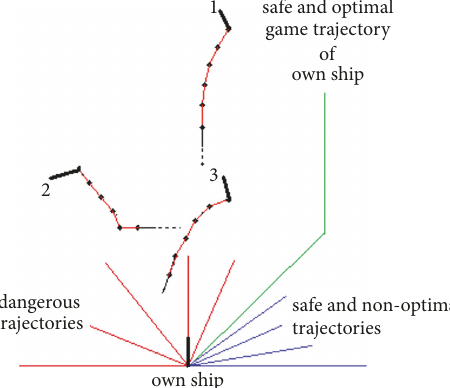
Figure 1: The situation of own ship passing of 𝑗 = 1, 2,. .. ,𝐽 encountered ships.